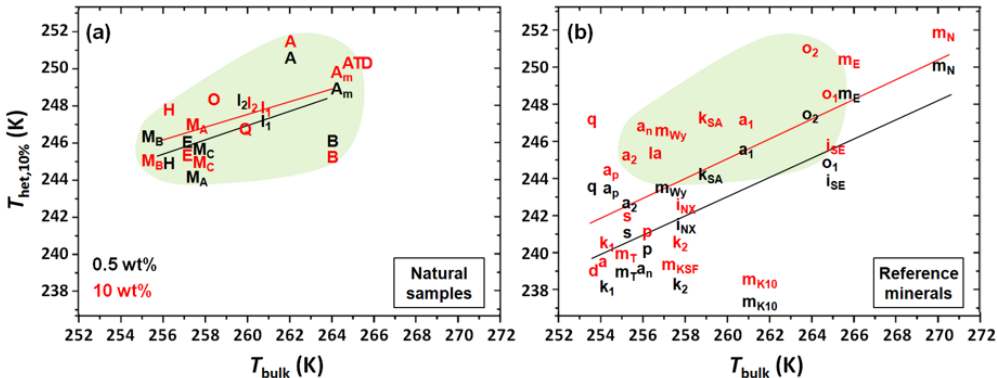
Figure 6. Correlation between bulk and emulsion freezing of the natural dust samples (panel a ) and reference samples (panel b ). Average bulk freezing temperatures are plotted against temperatures of 10% heterogeneously frozen fraction ( T het , 10% ) for suspensions with con- centrations of 0.5wt% (black numbers) and 10wt% (red numbers). Slopes are 0.0007 ± 0.0004 (0.5wt% suspension) and 0.0006 ± 0.0003 (10wt% suspension) for the natural dust samples (panel a ) and 0.0009 ± 0.0003 (0.5 and 10wt% suspensions) for the reference samples (panel b ). Sample code for the natural dust samples (panel a ): Antarctica (A), Antarctica milled (A m ) , Arizona test dust (ATD), Bolivia (B), Etosha (E), Hoggar (H), Israel 1 and 2 (I 1 , I 2 ) , Makgadikgadi A, B and C (M A , M B , M C ) , Oman (O), Qatar (Q). Sample code for the reference minerals (panel b ): ankerite (a), dolomite (d), quartz (q), adularia 1 and 2 (a 1 , a 2 ) , microcline E and N (m E , m N ) , orthoclase 1 and 2 (o 1 and o 2 ) , sanidine (s), albite (pericline) (a p ) , anorthite (a n ) , labradorite (la), plagioclase (p), illite NX and SE (i NX , i SE ) , kaolinite KGa-1b, KGa-2 and SA (k 1 , k 2 , k SA ) , montmorillonite K-10, KSF, STx-1b, and SWy-2 (m K10 , m KSF , m T , m Wy ) . Green shading: typical freezing temperatures of natural